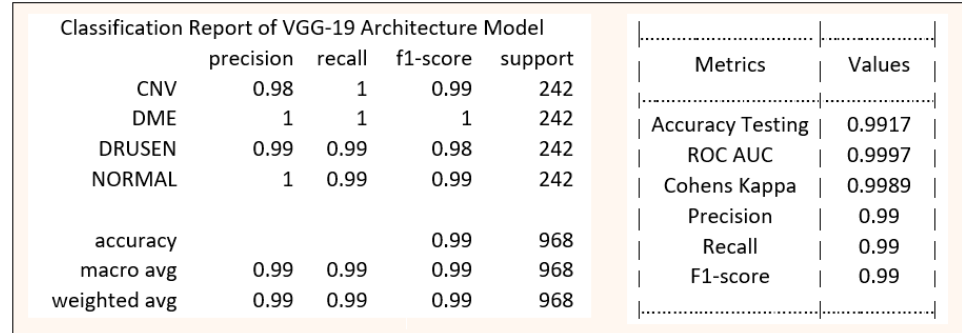
Figure 7. Final Classification report of VGG-19 based Model .